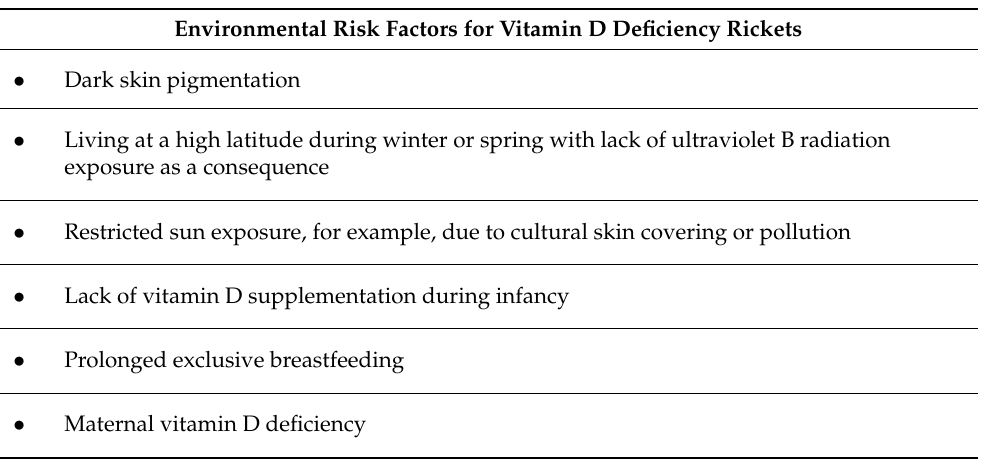
Table 3. Environmental risk factors for vitamin D deficiency